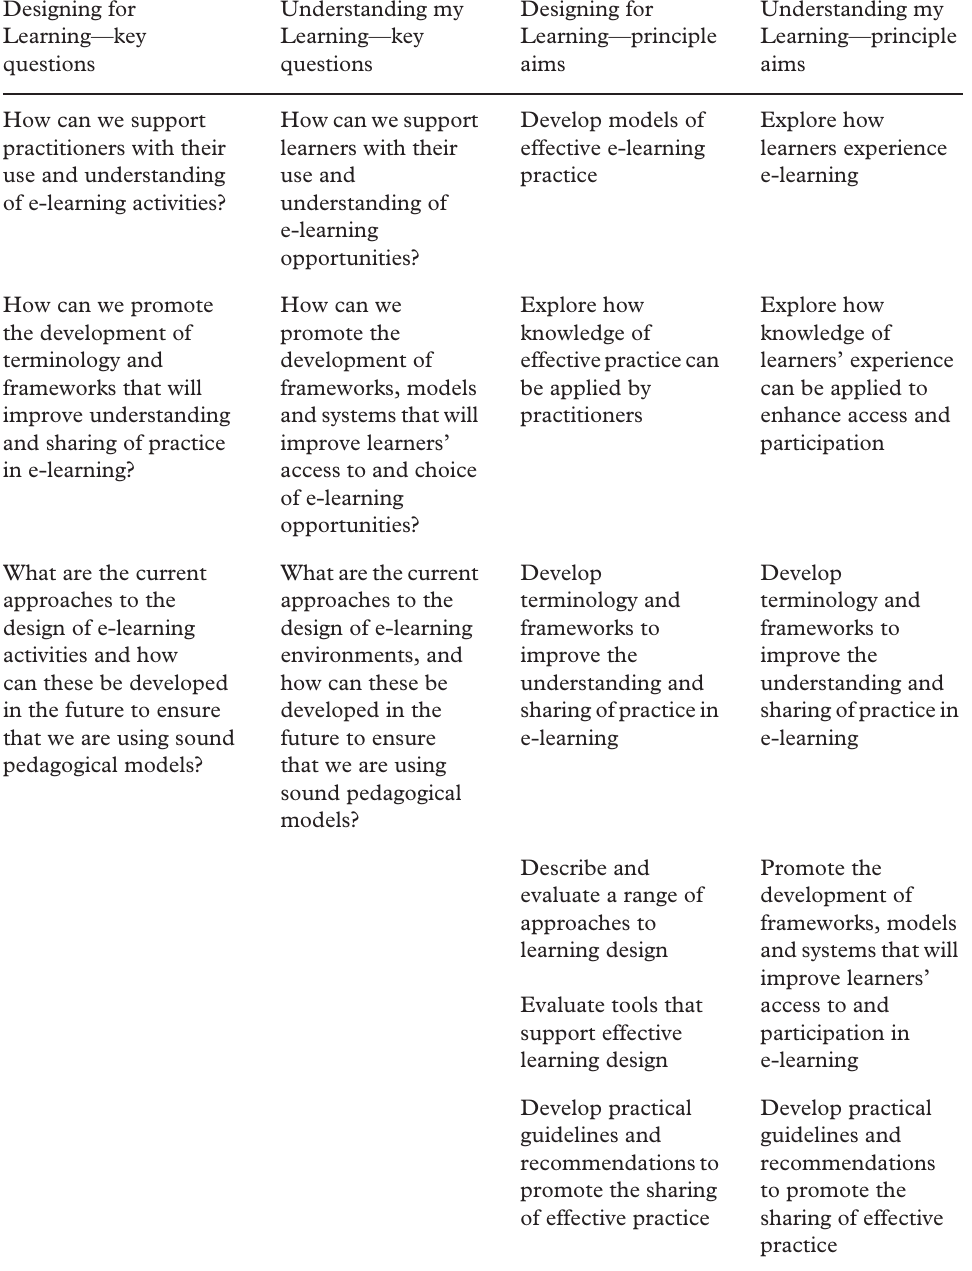
Table 1. Key questions and aims for the e-Learning and Pedagogy strand Designing